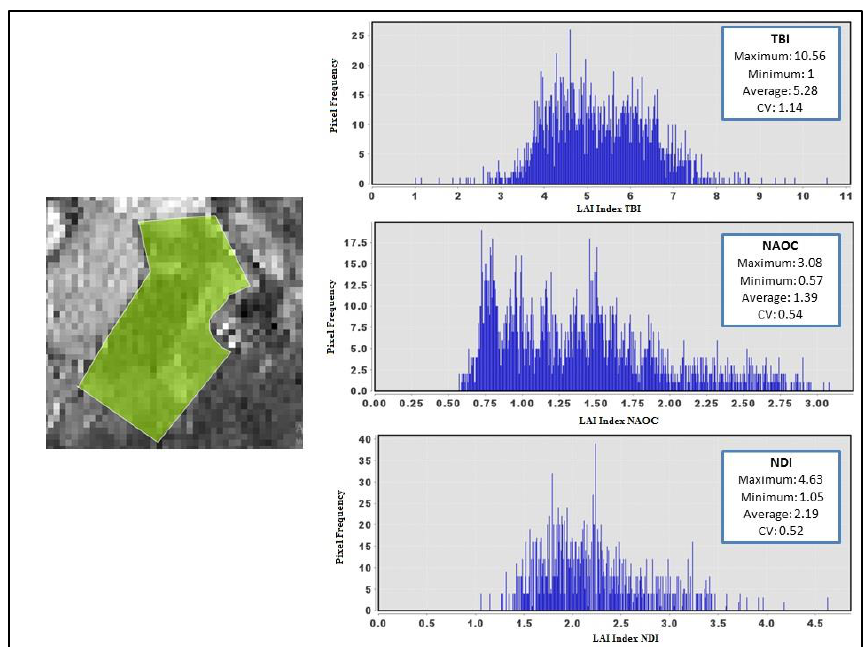
Figure 12. Area of interest (Piatã and Decumbens grassland) and the pixel frequency histogram for the LAI variable, based on the vegetation indices studied: TBI, NAOC, and NDI, showing the minimum, maximum, average and coefficient of variation (CV).